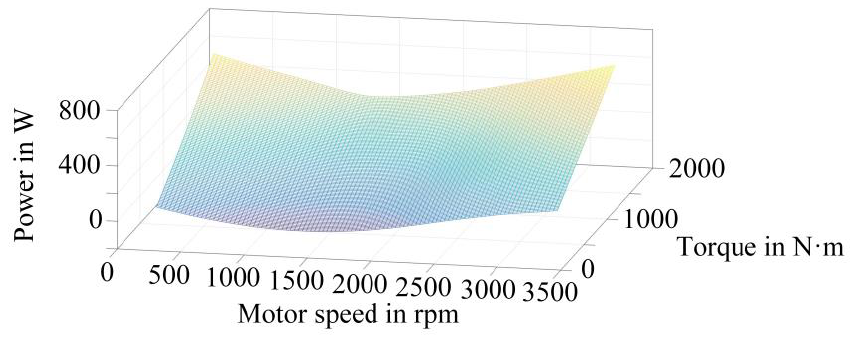
Figure 6. Power loss-speed-torque data space of FWD.